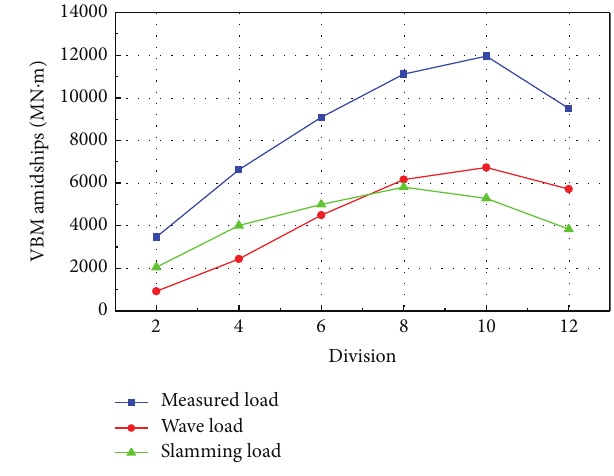
Figure 8: VBM components along ship (scheme 1).